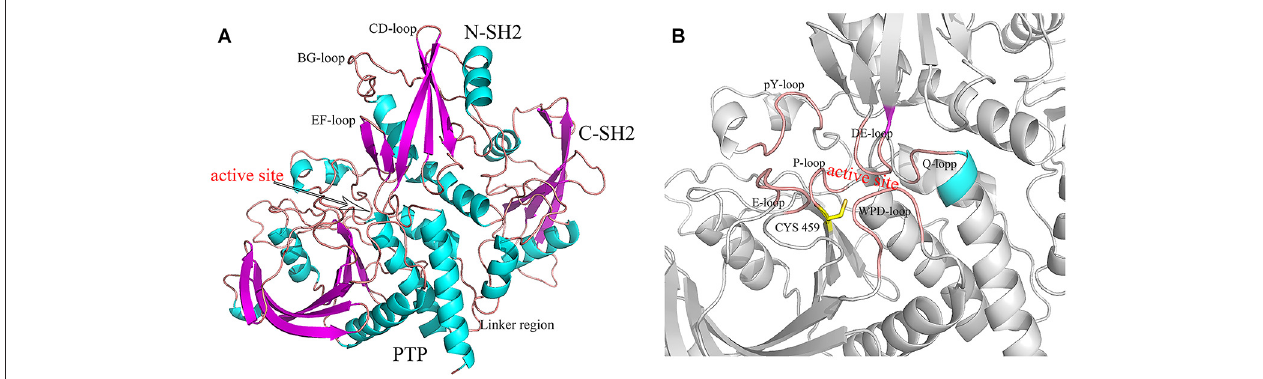
FIGURE 1 | The structure of SHP2 (A) and the active site (B) . The key regions were